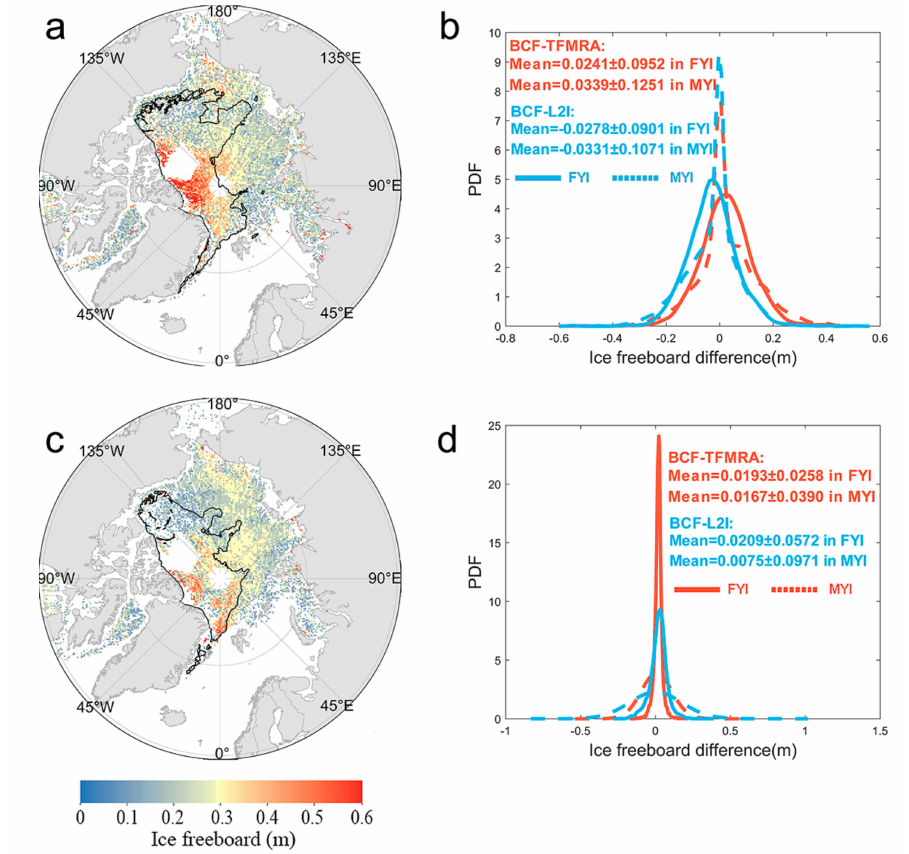
Figure 5. Ice freeboard from BCF ( a and c ), probability density function of ice freeboard di ff erence between BCF and TFMRA, BCF and CS-2 L2I products in March 2015 ( b ) and April 2016 ( d ). The black polygon defines the extent of the MYI